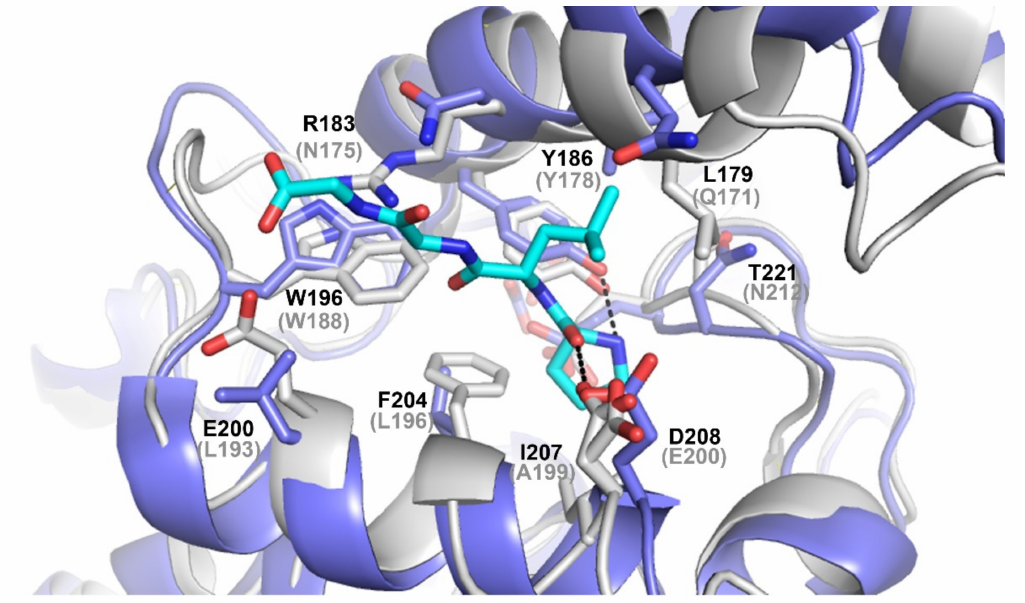
Figure 6. Superposition PsyPAH (white tones) and APF1 bound to PLGG peptide (PDB 1XQY, main chain in blue tones, peptide in sky blue tones). The numbering of the enzymes is that which appears in the corresponding PDBs (PsyPAH, black numbering; APF1, grey